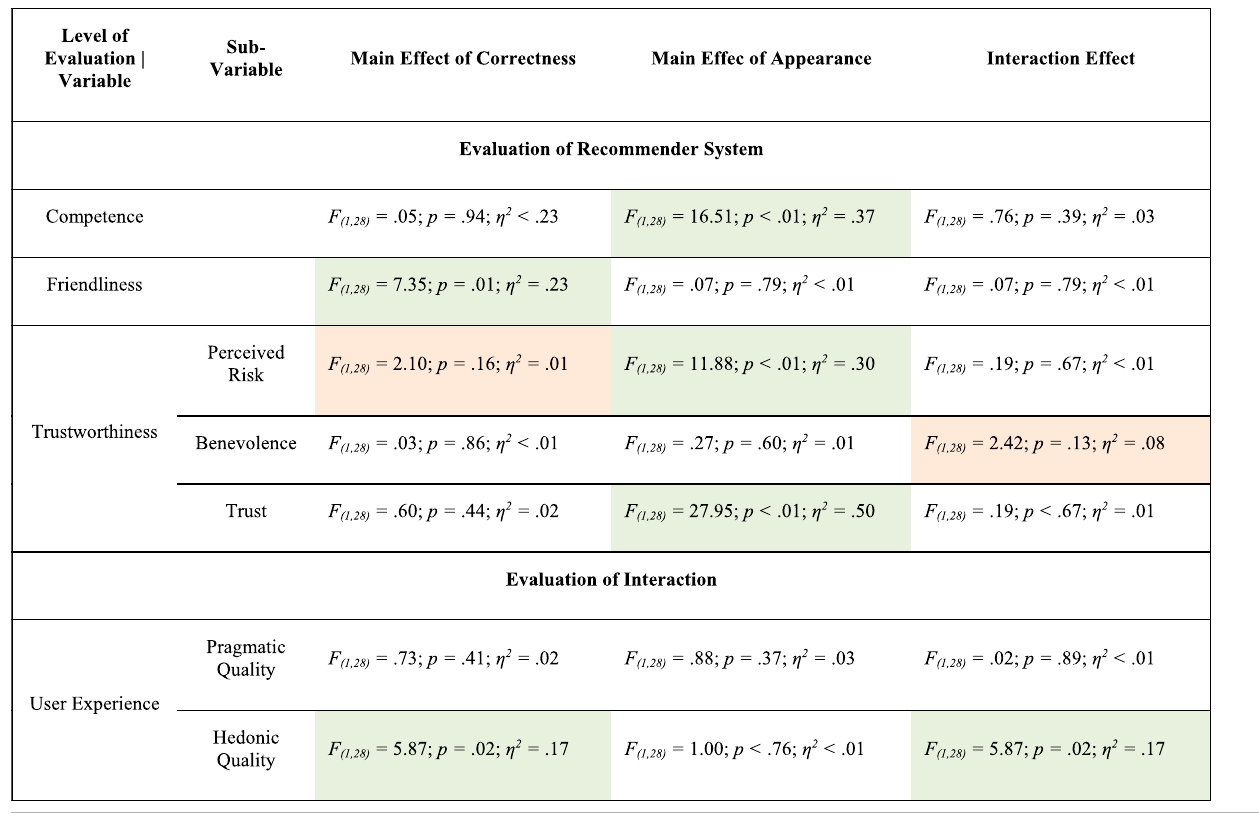
Frontiers in Virtual Reality |